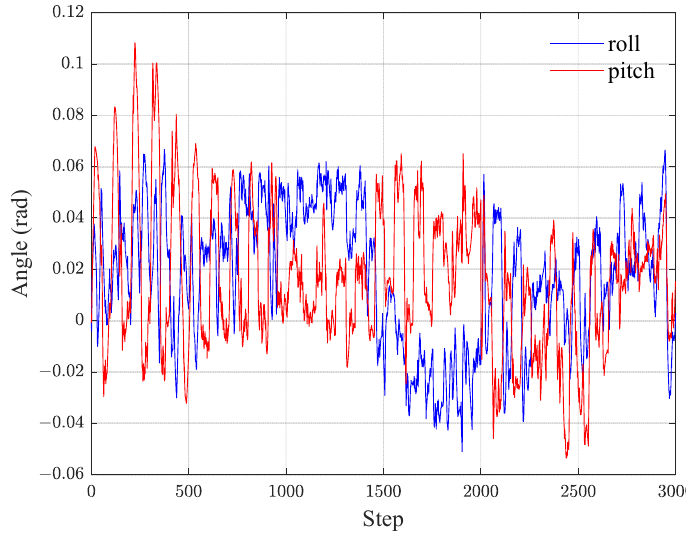
Figure 8. The roll and pitch angles of the robot in motion.